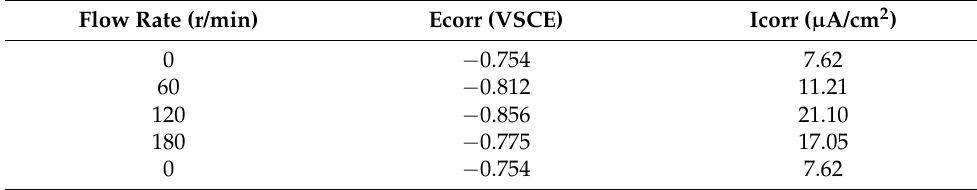
Table 6. Corrosion electrochemical parameters of P110 steel at different flow rates. Flow Rate